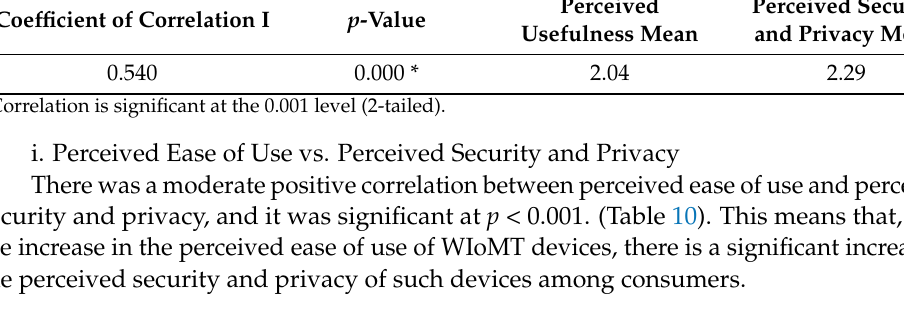
Table 10. Correlation between perceived ease of use and perceived security and privacy.